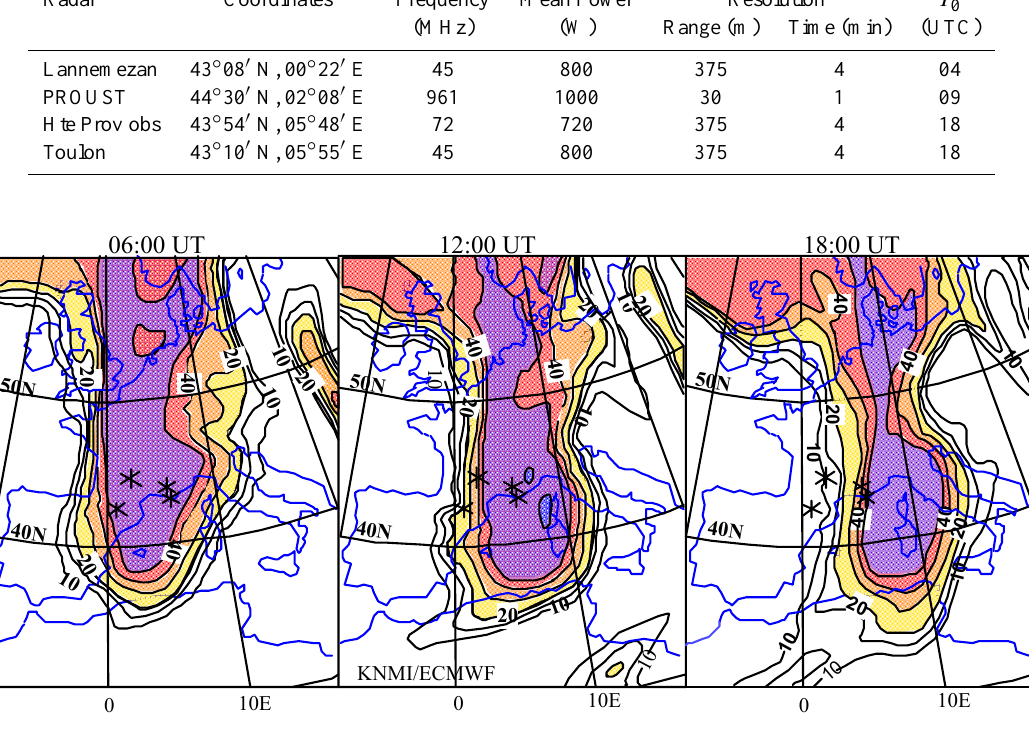
Fig. 1. ECMWF analysis on Saturday, 4 March 1995. Potential vorticity on the 300 hPa isobaric surface at 0600 UT (left), 1200 UT (center) and 1800 UT